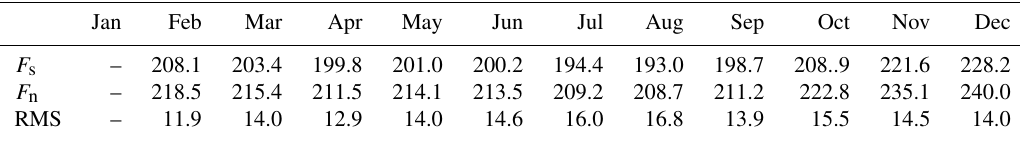
Table 3. SW flux comparisons between NISTAR and CERES SYN1deg for all coincident observations of 2017. F n is the NISTAR flux (Wm − 2 ), F s is the SYN flux (Wm − 2 ), and RMS is the root mean square error between them (Wm − 2 ). Jan